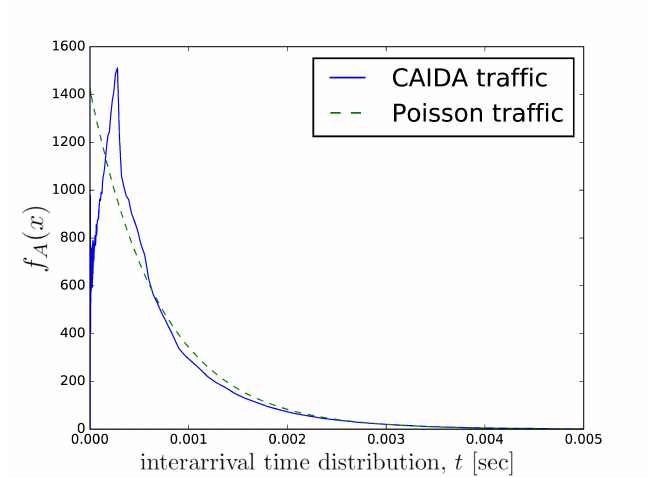
Figure 5. Packet interarrival times of IP traffic and CAIDAmeasurements versus Poisson distribution.